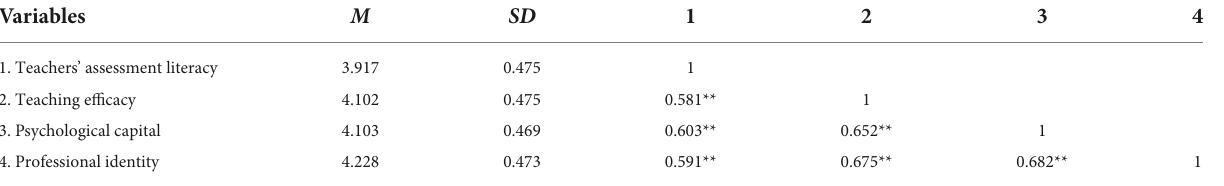
TABLE 1 Descriptive statistics and correlation matrix variables.